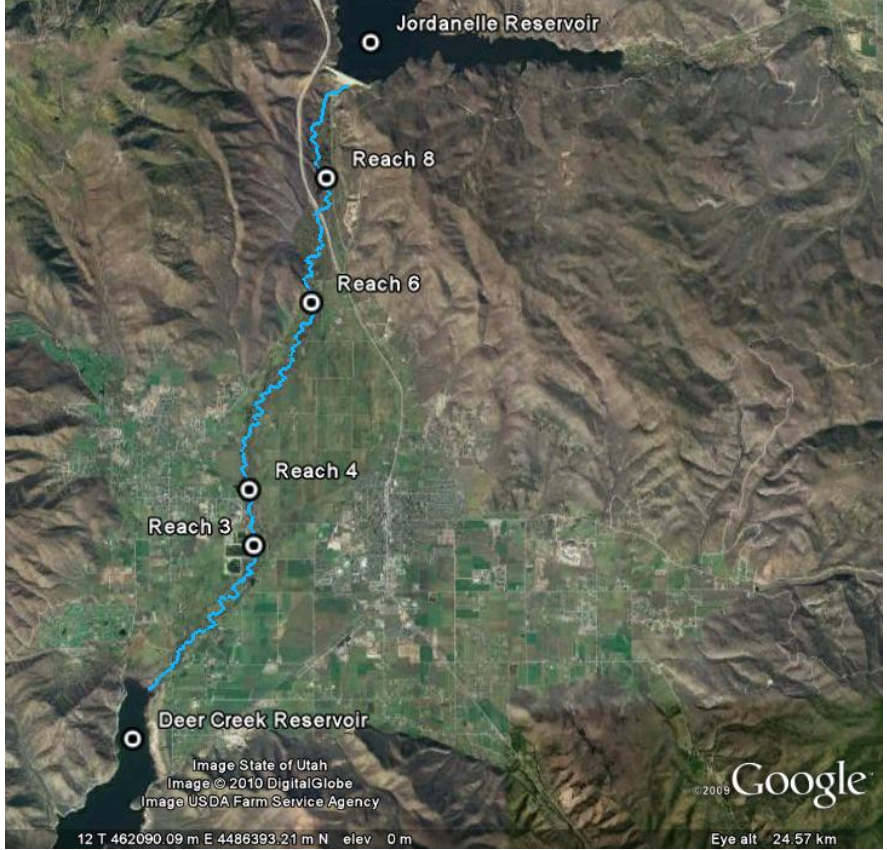
Figure 1. Aerial view of the study area. The Provo River is drawn in blue; it flows south–southwest. Study sites and reservoirs on the river are labeled. Map created in Google Earth ® (https://www.google.com/earth/; Mountain View, CA,